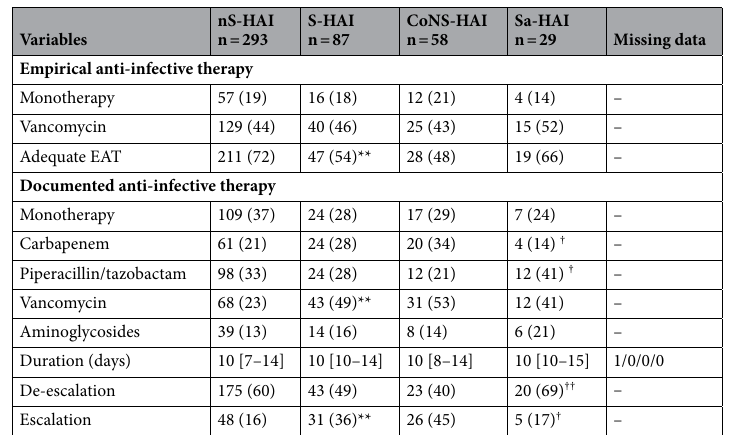
Table 3. Anti-infective therapies of the four groups of patients with HAI. nS-HAI infection without staphylococci peritoneal cultures, S-HAI infection with positive staphylococci peritoneal culture, Sa-HAI infection with Staphylococcus aureus positive peritoneal culture, CoNS-HAI infection with coagulase-negative staphylococci peritoneal culture, EAT empirical anti-infective therapy, HAI hospital-acquired postoperative intra-abdominal infection, ICU intensive care unit. [25th–75th]: [25th–75th percentiles]. °Results obtained in survivors. **p < 0.01 between the nS-HAI and S-HAI groups; † p < 0.05 and †† p < 0.01 between the CoNS-HAI and Sa-HAI groups.